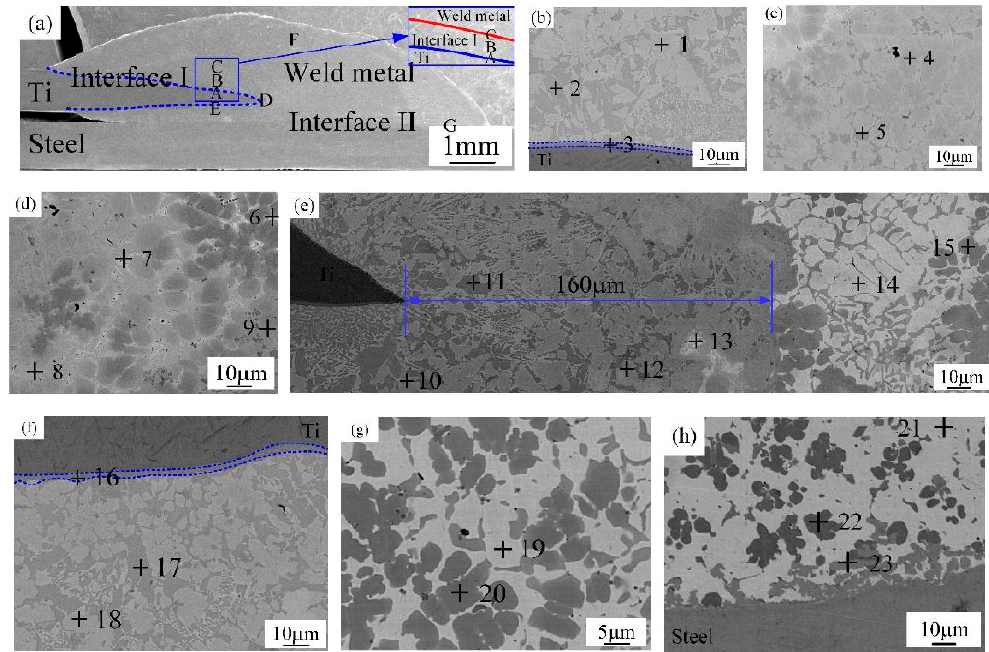
Figure 6. The microstructure of Joint II (sample #2); ( a ) the cross-section sample, ( b ) magnified zone A in Figure 6a, ( c ) magnified zone B in Figure 6a, ( d ) magnified zone C in Figure 6a and ( e ) magnified zone D in Figure 6a. Table 5. EDS analysis results of various zones for Joint II (specimen #2) in Figure 6 (at. %). Point.